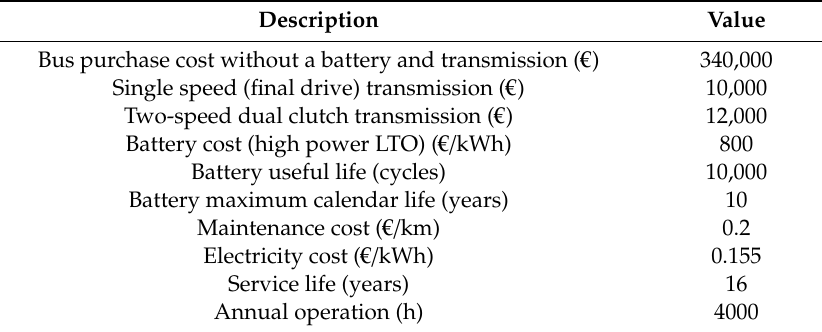
Table 3. Lifecycle cost